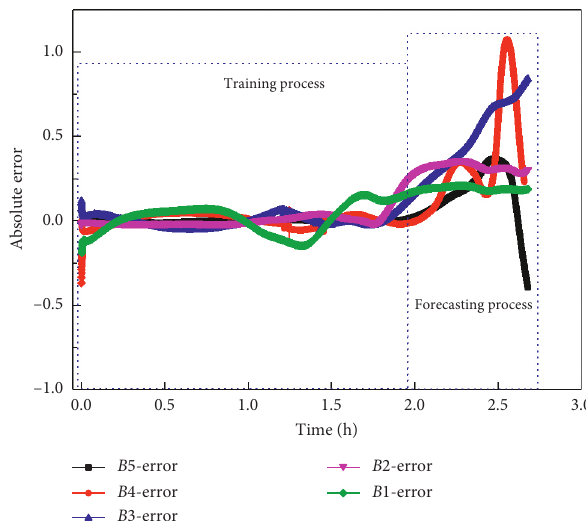
Figure 4: Actual and forecasting error of current scenario. Table 1: Comparison of performance of parallel battery